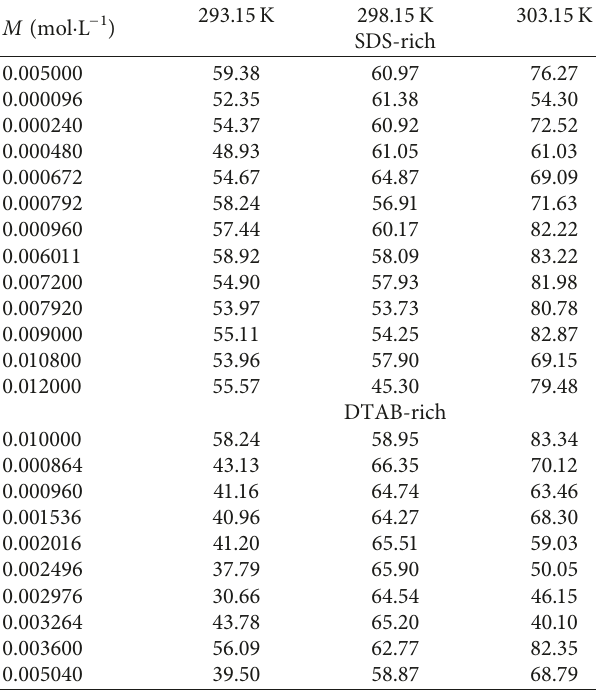
Table 10: Hydrodynamic radius ( R rich surfactants in the aqueous medium at the three different temperatures T � 293.15, 298.15, and 303.15K and at 0.1MPa. M (mol · L − 1